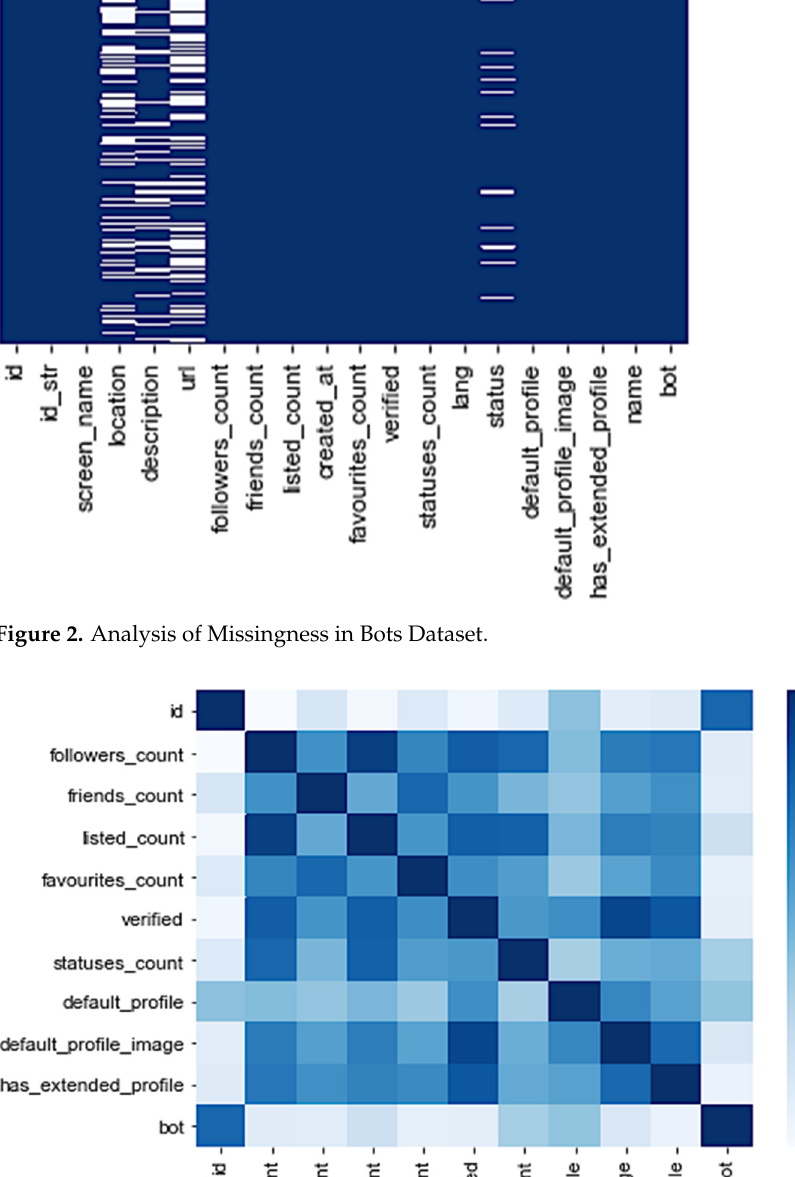
Figure 4. Study of Correlated Parameters . 5.2. Exploratory Data Analysis For our exploratory data analysis, we have employed several crux parameters to ex- amine the difference in the natures of a bot and a non-bot profile. This includes inspection of relevant attributes and features that eventually become prominent in our model build- ing phase. Figure 5 illustrates that the bot users often try to conceal their personal infor- mation. This is apparent from the graph where most of the profile-based parameters for bots are missing. This indicates collusion in the online social network caused by such sus- picious users. A smaller amount of information on the public domain actually helps these bots to rapidly disappear after fraudulent indulgence.